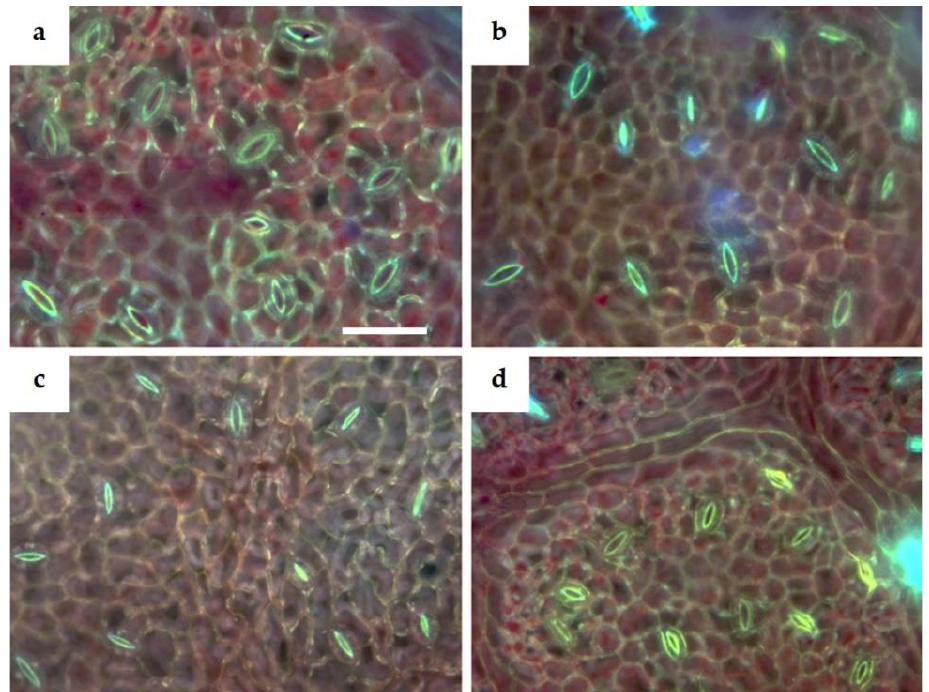
Figure 3. Epi-fluorescence microscopy views of abaxial leaf epidermis of V. vinifera ‘Falanghina’ vines at the four study sites: SL-Santa Lucia ( a ), CA-Calvese ( b ), GR-Grottole ( c ), AC-Acquafredde ( d ). Images are all at the same magnification. Bar = 50 µm. Table 3. Effects of field (F), year (Y), and their interaction (F x Y) on stomata traits of V. vinifera subsp. vinifera ‘Falanghina’ vines at the four study sites: SL-Santa Lucia, CA-Calvese, GR-Grottole, AC-Acquafredde. Mean values and standard errors are shown. Stomata